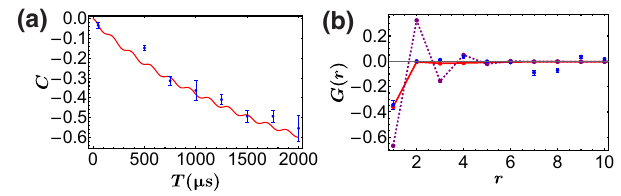
FIG. 4. Similar experiments for antiferromagnetic Ising model. (a) For two ions, considerable change in the two-spin cor- relation from 0 to about − 0.6 (which corresponds to a change in the defect density from 0.5 to 0.2) can still be observed as we increase the total quench time up to T = 5 τ = 2 ms under the coupling J 0 = 2 π × 265 Hz. (b) However, for N = 13 ions, the spatial correlation under J 0 = 2 π × 67 Hz α = 1.05 and T = 5 τ = 4 ms is much weaker (blue dots for experimental data and red solid line for theoretical prediction). This is due to the much smaller energy gap for the antiferromagnetic case. To observe significant spatial correlations, 20-ms total evolution time will be needed (purple dashed